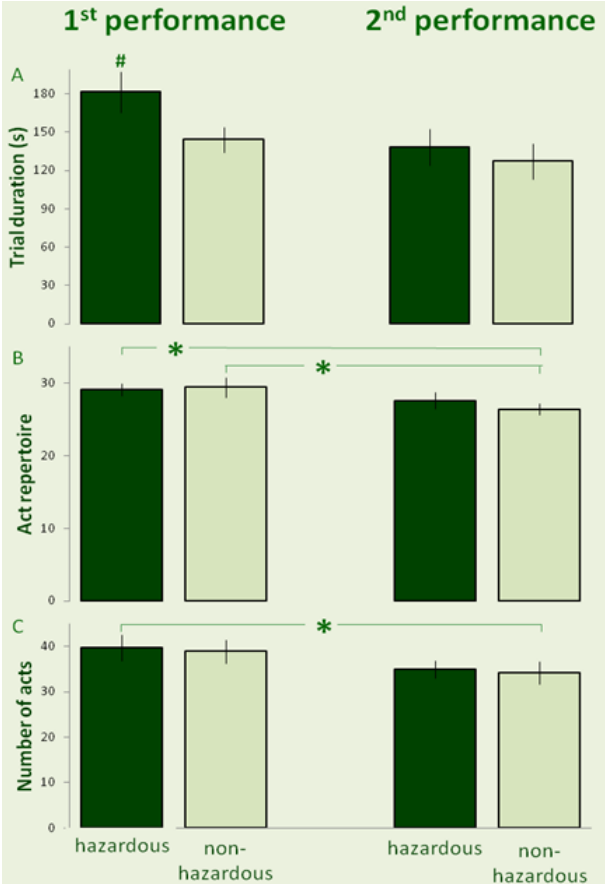
Figure 1. The mean (± SE) of trial duration ( A ), act repertoire ( B ), and the total number of acts ( C ) are depicted for hazardous (dark bars) and non-hazardous trials (light bars) during the first performance (left-hand insets) and second performance (right-hand insets). # indicates a significant difference compared to all other trials. (* indicates a difference between the trials, connected by the horizontal